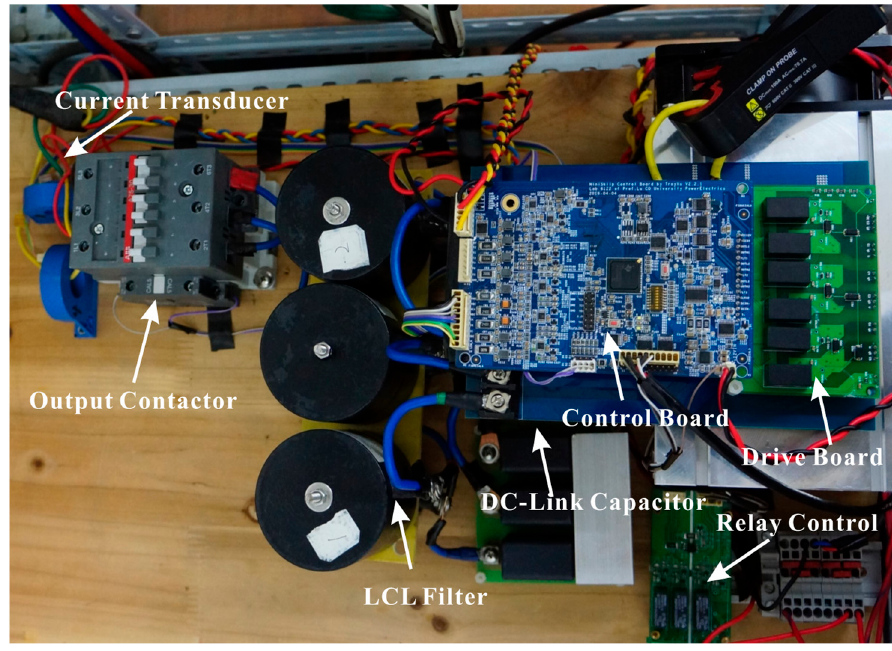
Figure 7. The flexible three-phase grid-tied VSC prototype.